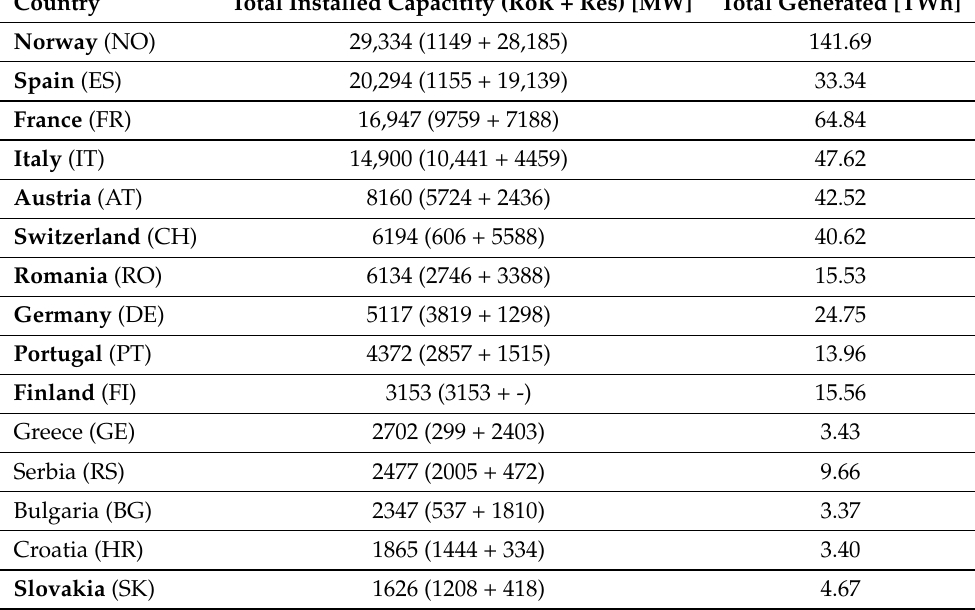
Table 1. Top fifteen EU countries by installed hydropower capacity in 2020 (excluding pumping storage). We show in bold the countries considered in this